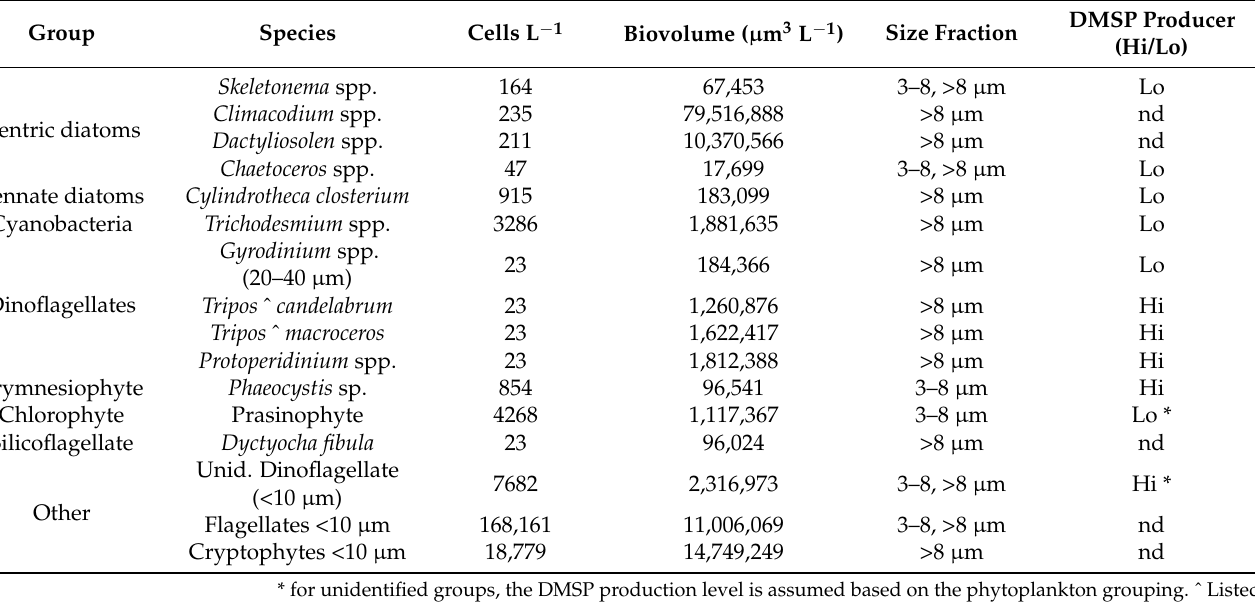
Figure 3. Correlations between the different DMSP concentrations. Control samples (light grey) and enriched DMSP samples (black) for time 0 h (circles), 3 h (squares), and 6 h (diamonds) are represented for DMSPd vs. DMSPt ( A ), DMSPp vs. DMSPt ( B ), and DMSPp vs. DMSPd ( C ). Signif- icant correlation: ( A ) r 2 = 0.668, p = 0.002. 3.3. Fractioned Community Incubation Experiment Concentrations of DMSP for the fractionated community showed similar responses across the different fractions with decreasing concentrations of DMSPt and DMSPd and increasing concentrations of DMSPp for the +DMSP samples (Figure 4). In the controls of the largest fraction (>8 µm), DMSPt remained stable at around 38 nM while DMSPd de- creased significantly from 8.77 to 3.44 nM (paired t -test, t06 = 5.7967, p = 0.003), and DMSPp increased (paired t -test, t06 = 6.3069, p = 0.002) from 29.14 to 37.51 nM (Figure 4A– C). In the +DMSP samples, DMSPt decreased from 142.84 to 89.21 nM (paired t -test, t06 = 3.1152, p = 0.019), as did DMSPd from 80.87 to 42.62 nM (paired t -test, t06 = 5.5153, p = 0.003) while there was an increase in DMSPp from 29.59 to 73.58 nM (paired t -test, t06 = 3.4614, p = 0.016) (Figure 4A–C). Table 4. Relative loss/gain and rate of DMSP for each size fraction and treatment for DMSPt, DMSPd and DMSPp. This is a numerical summary of data presented in Figure 4. Relative loss/gain was calculated as % of DMSP lost/gained relative to its initial concentration (i.e., Δ Concentration / initial concentration × 100). Loss/gain rates were determined as the change in concentration over time and obtained from the slope of the linear regression. Samples with no significant ( p > 0.05) DMSP loss or gain between initial and final time have been omitted and are indicated with a dash. Samples that lose DMSP over time are indicated with negative values and samples that gain DMSP over time are indicated with positive values. Data show mean +/ − SD and n = 3 *. DMSP total